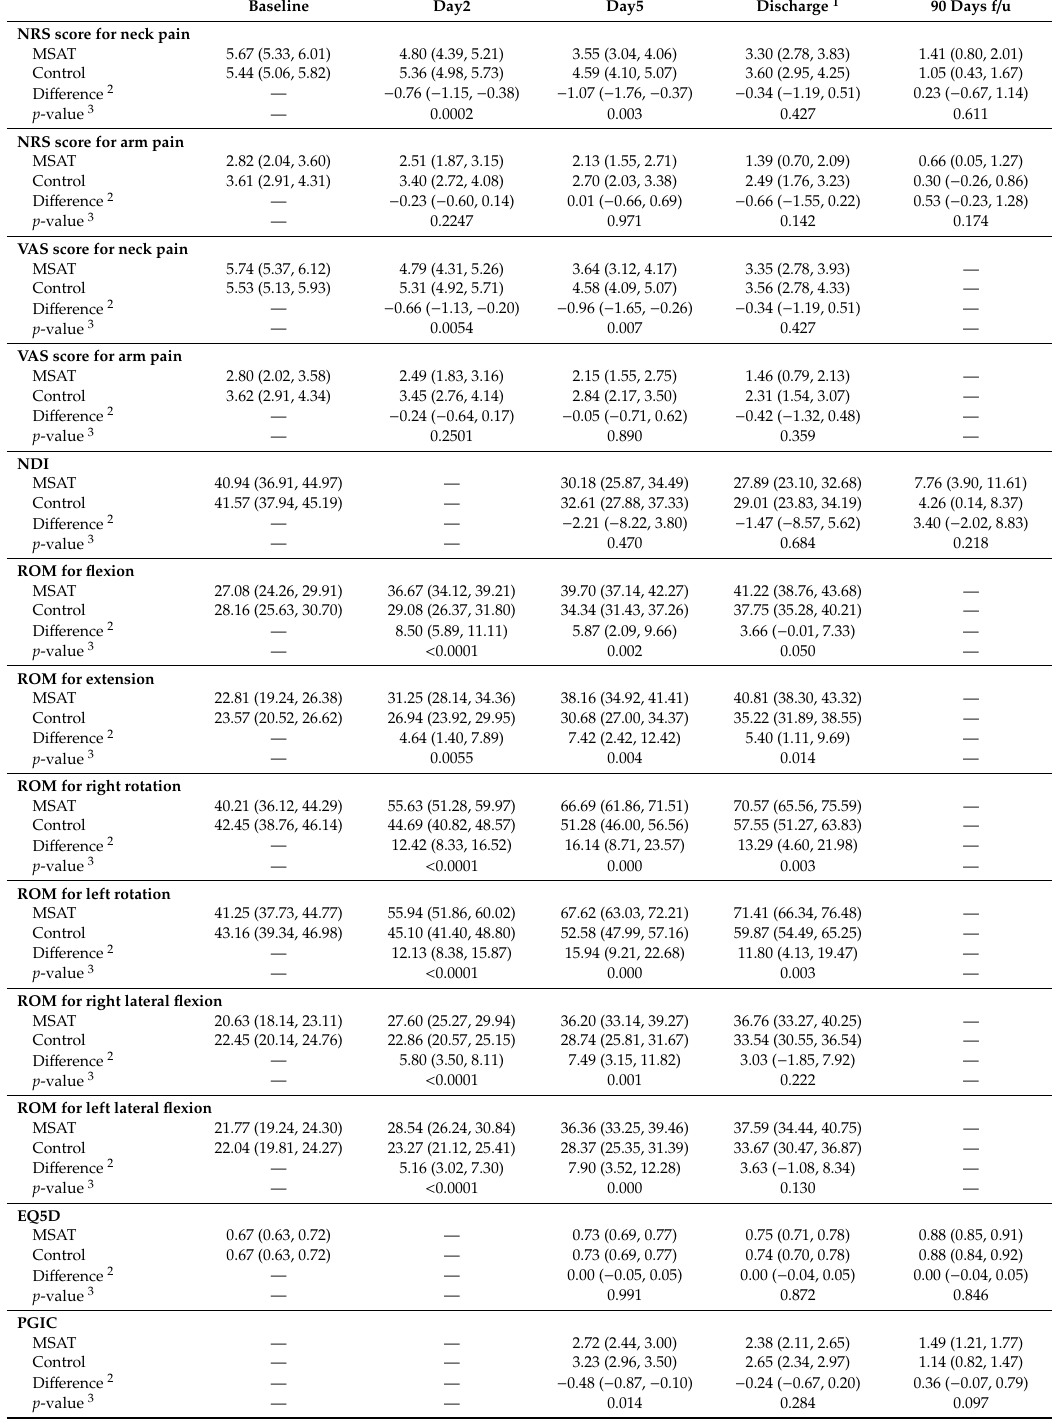
Table 2. Comparison of outcomes at each measuring point between the MSAT and control